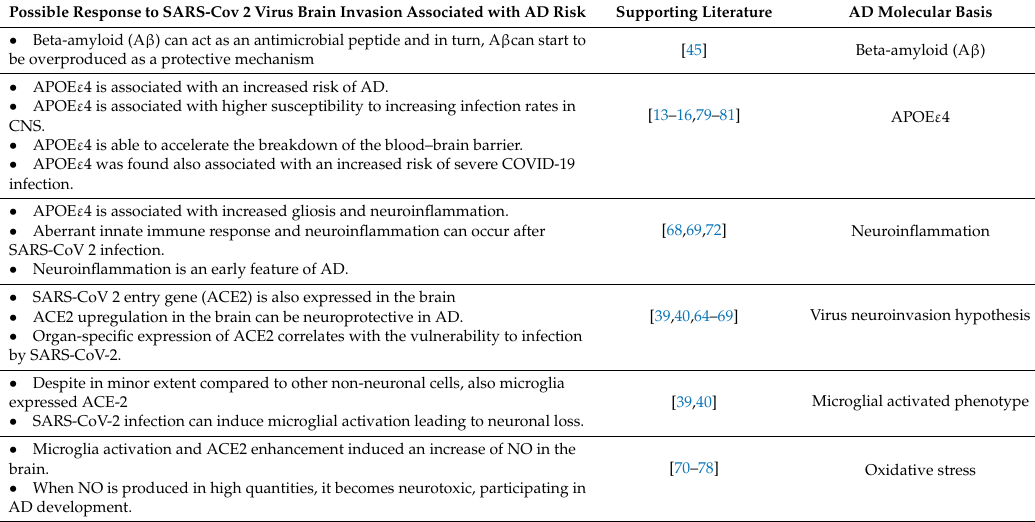
Table 1. Theoretical impact of SARS-CoV-2 brain infection on Alzheimer’s disease risk.